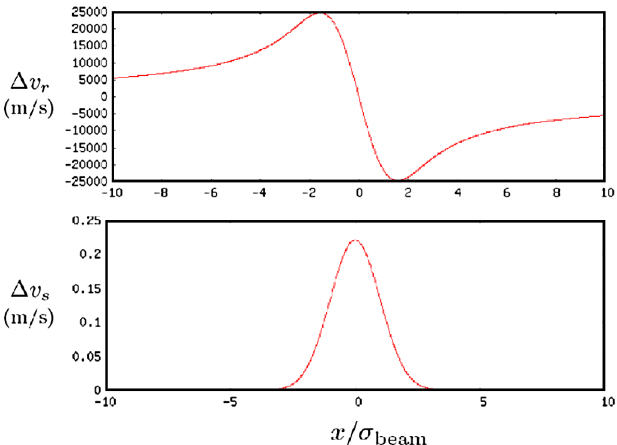
FIG. 2. (Color) Transverse (top) and longitudinal (bottom) kick component in m = s vs transverse ion position in units of the rms beam